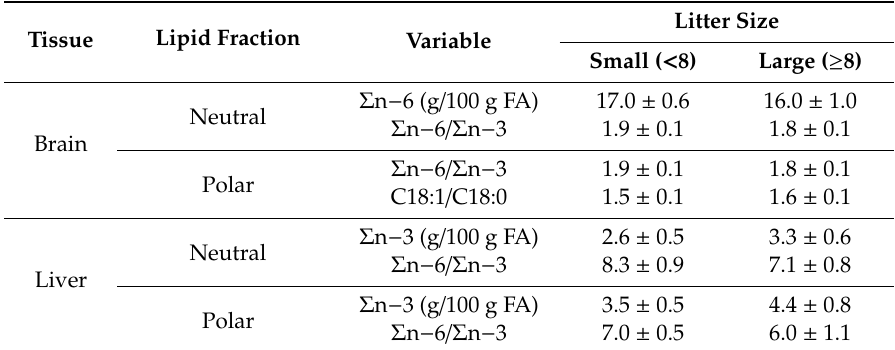
Table 5. Highlighted significant di ff erences ( p < 0.05) in fatty acid composition of brain and liver between piglets from small and large litters at 180 days